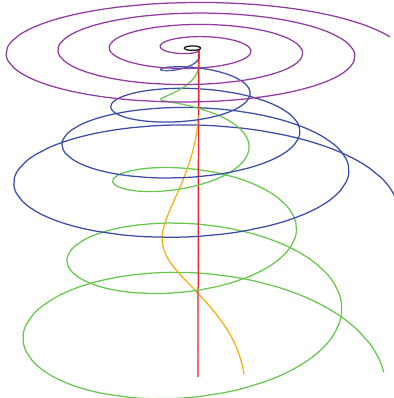
Figure 3: The spiral string solution in AdS 5 spacetime corresponding to quark undergoing a circular motion. The curves are drawn for di ff ering values of the quark velocity v on the boundary (cid:3) values of v and color-coding are the same as in Figure 2 (cid:4) . The small black circle on the top is the quark trajectory on the AdS boundary; the vertical direction corresponds to the bulk radial